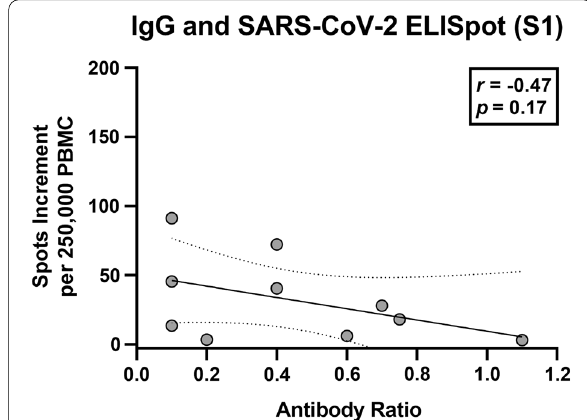
Fig. 2 Spearman correlation analysis of SARS-CoV-2 specific IgG and Spike (S) 1 specific ELISpot responses in patients with multiple sclerosis ( n 10). The bold, continuous line indicates the regression = line, the dashed lines the 95% confidence interval